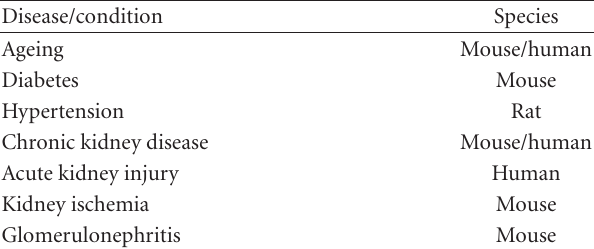
Table 1: Conditions and disease states associated with reduction in